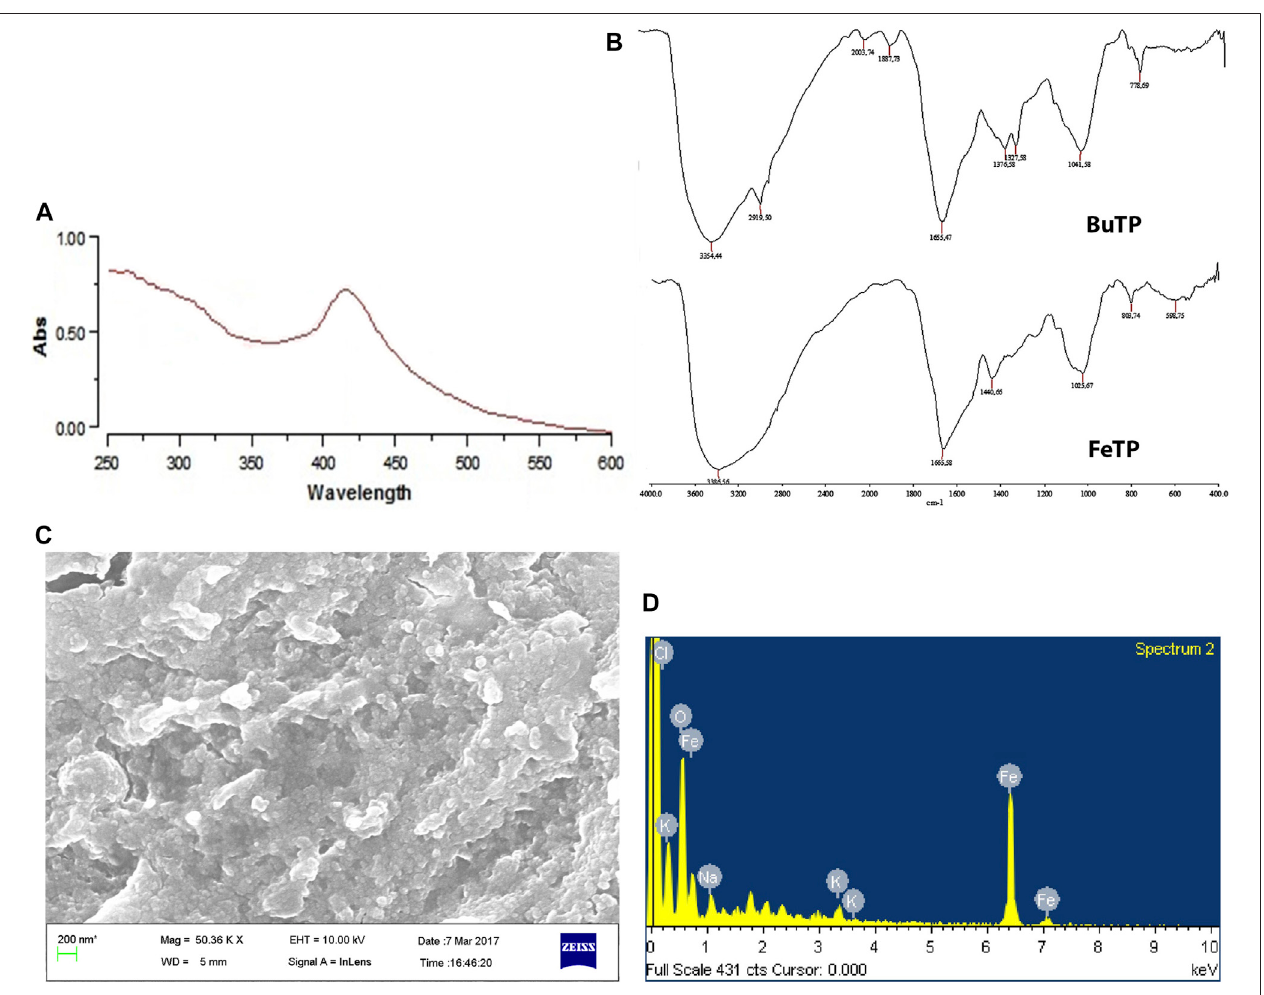
FIGURE 2 | Characterization of green synthesized FeTP by (A) UV Visible spectra, (B) FT-IR (Top: BuTP, Bottom: FeTP), (C) FESEM micrograph, and (D) EDX spectrum.